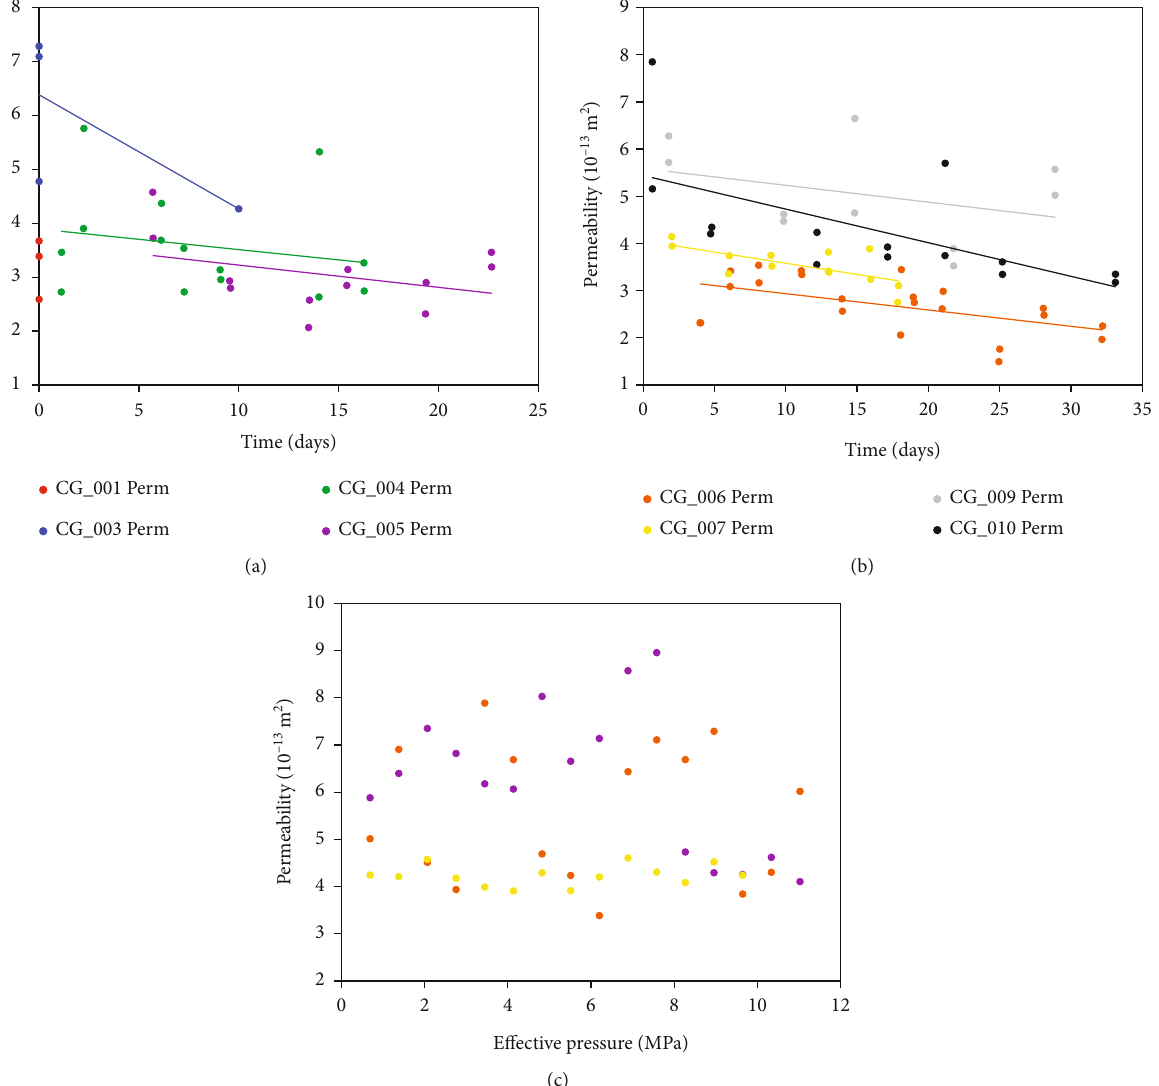
Figure 7: Permeability determinations: (a) permeability as a function of time during 8-hour cycle tests; (b) permeability as a function of time during 4-hour cycle tests (CG_006, CG_007), 2-hour cycle tests (CG_010), and tests without stress cycling (CG_009); (c) permeability measured at intervals of 0.69MPa during the initial con fi ning pressure loading of CG_005, CG_006, and CG_007, prior to stress cycling